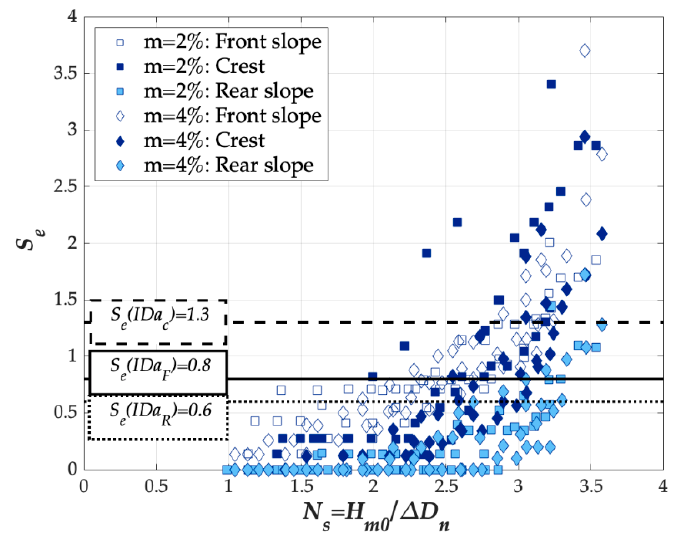
Figure 6. Armor damage data for cube-2L model and Initiation of Damage level for front slope (IDa F ), crest (IDa c ) and rear slope (IDa R ). (IDa F ), crest (IDa c ) and rear slope (IDa R